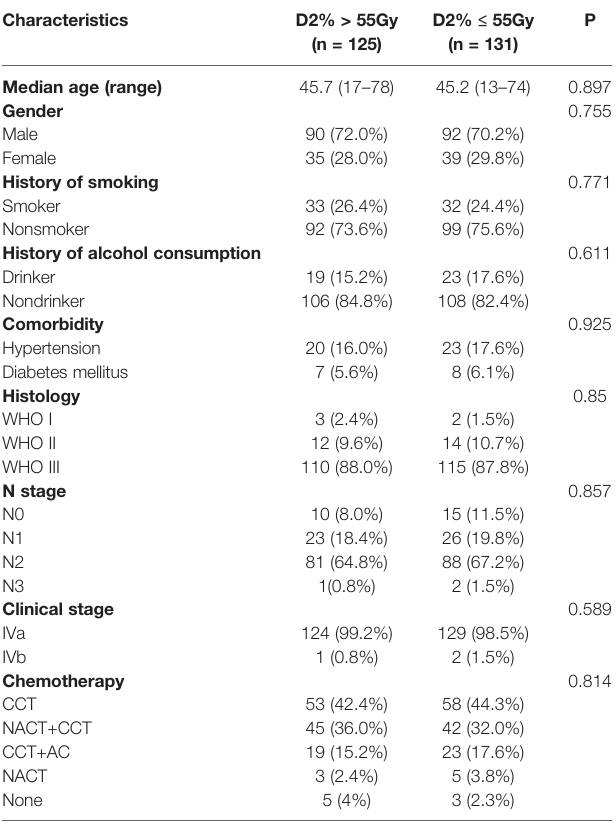
TABLE 1 | The baseline characteristics of patients. Characteristics